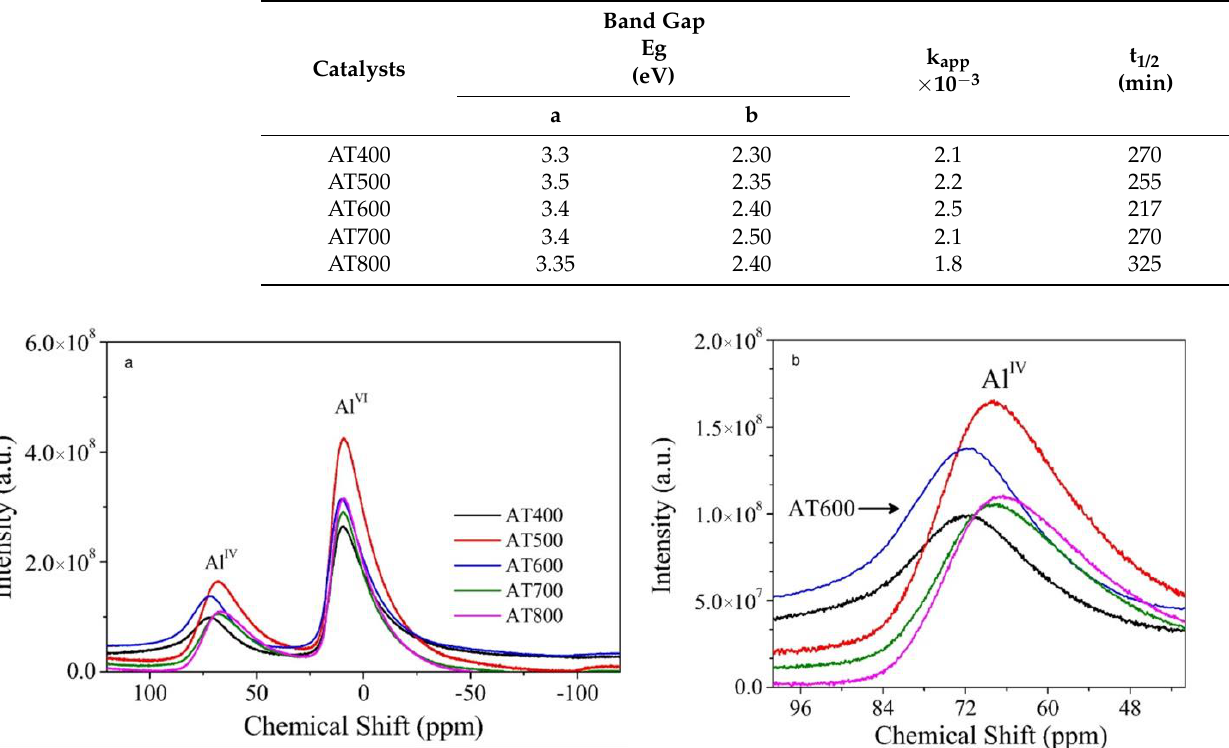
Table 2. Band gap energy (Eg), half time, and apparent first-order reaction constant for the AT series.